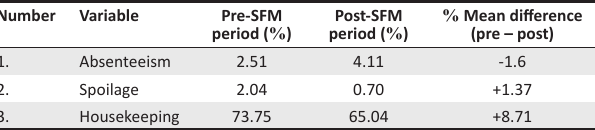
TABLE 3: Pre- and post-shop floor management percentage means comparison. Number Variable